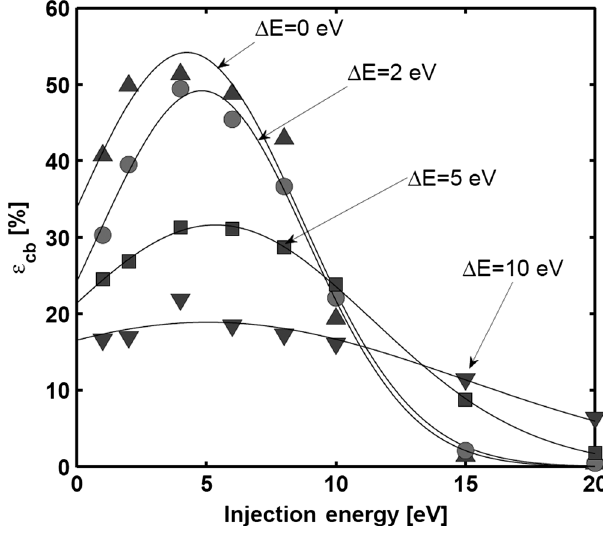
FIG. 4. 85 Rb 1 þ ions captured as a function of the injection energy inside the charge breeder for different values of the injected beam longitudinal energy spread. The reference curve corresponds to 2 eV. A Gaussian fit is superimposed on each numerical